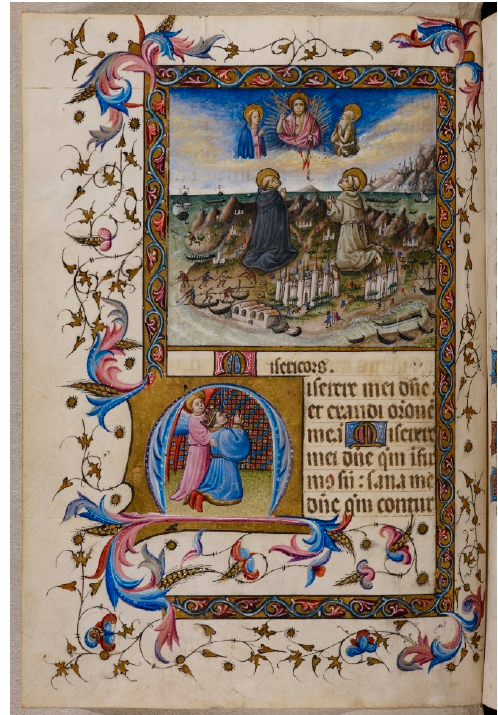
Figure 5. Psalter and Hours, Dominican use (the ‘Prayerbook of Alphonso V of Aragon’). London, British Library Add MS 28962, f. 67v. Used by permission.